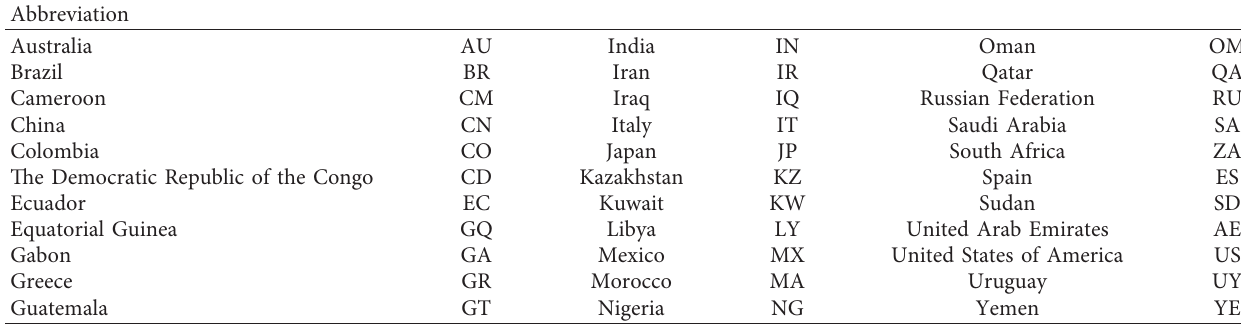
Table 5: Countries in the selected